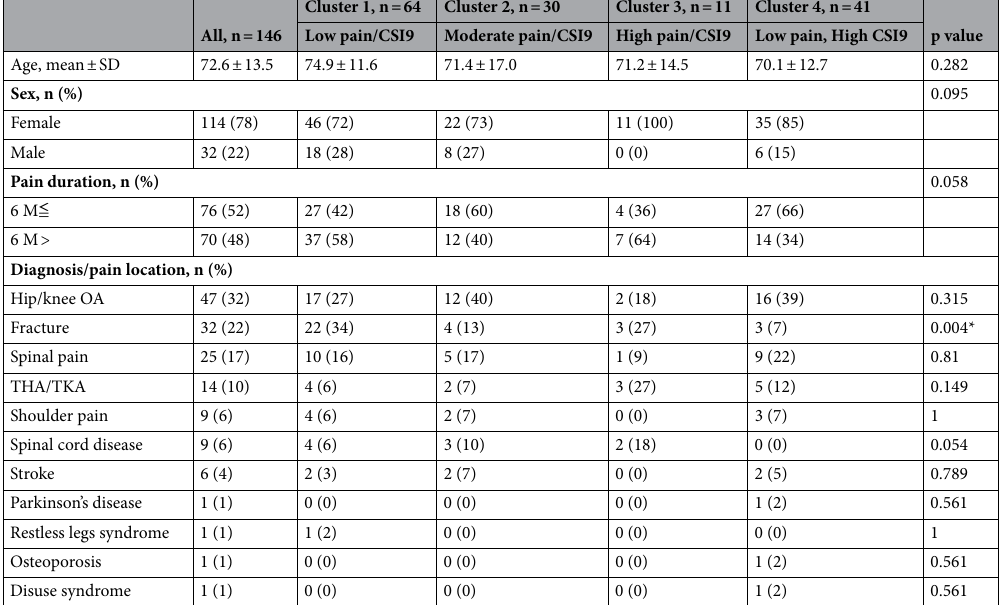
Table 2. Patients’ characteristics in each subgroup. CSI9 : central sensitization inventory-9 (CSI short form), OA osteoarthritis, THA total hip arthroplasty, TKA total knee arthroplasty. p value = Kruskal–Wallis test or X2 test or Fisher’s exact test. *Cluster1 >